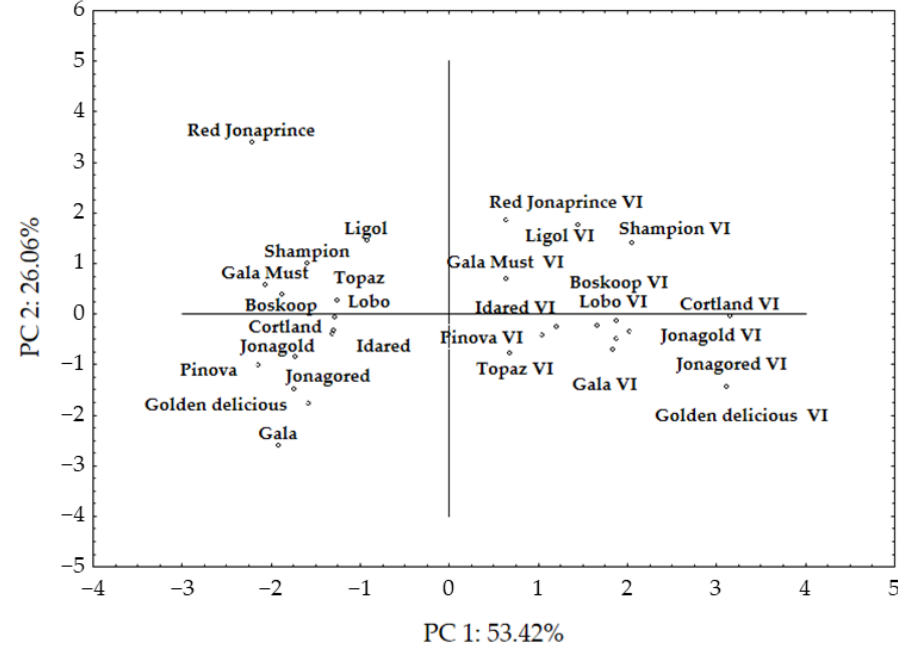
Figure 3. PCA score plot.